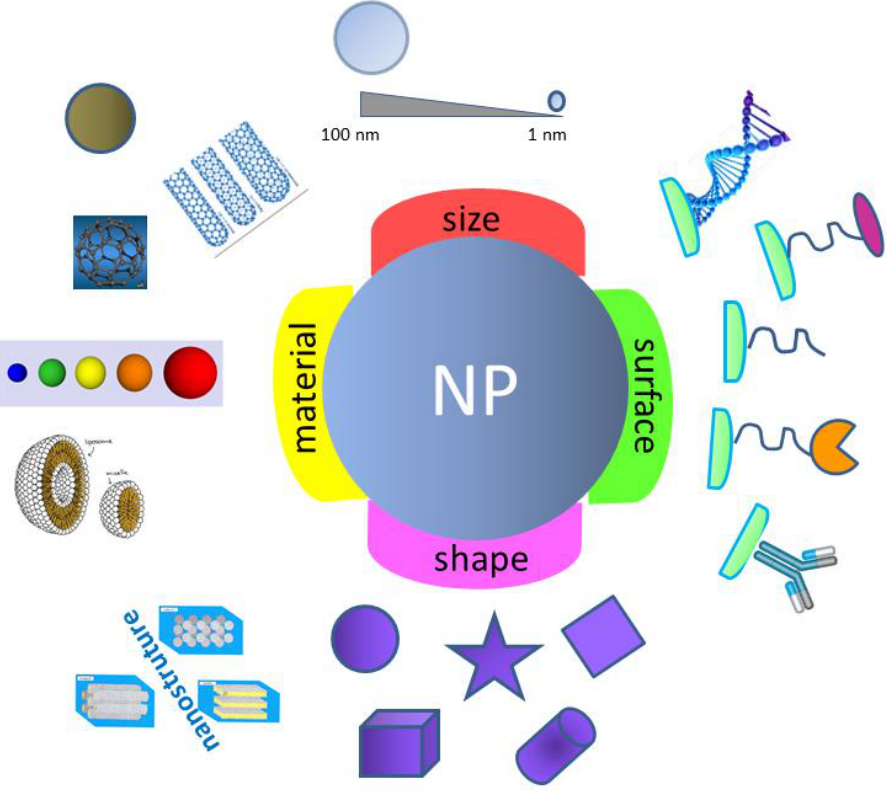
Figure 1. Engineered multifunctional NP.